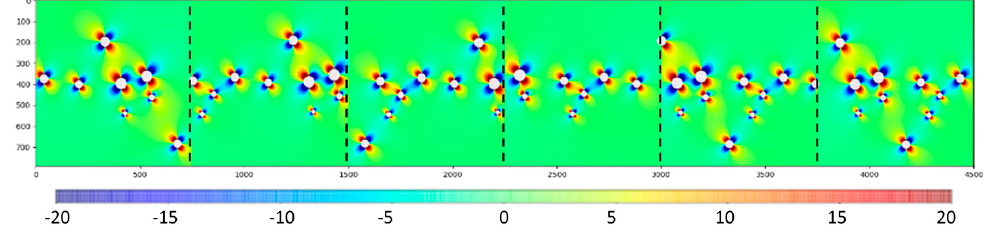
Figure 8. Fiber deviation map (°).